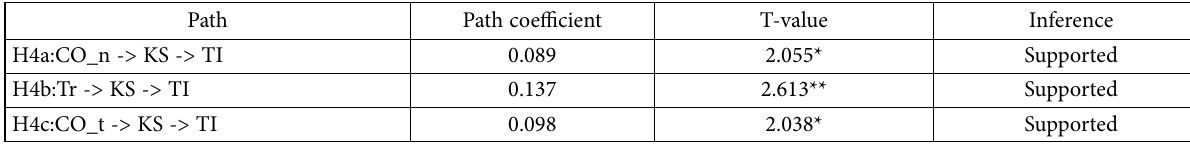
Table 7. The indirect effect of the knowledge sharing